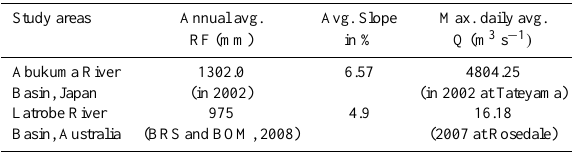
Table 4. Characteristics of the study